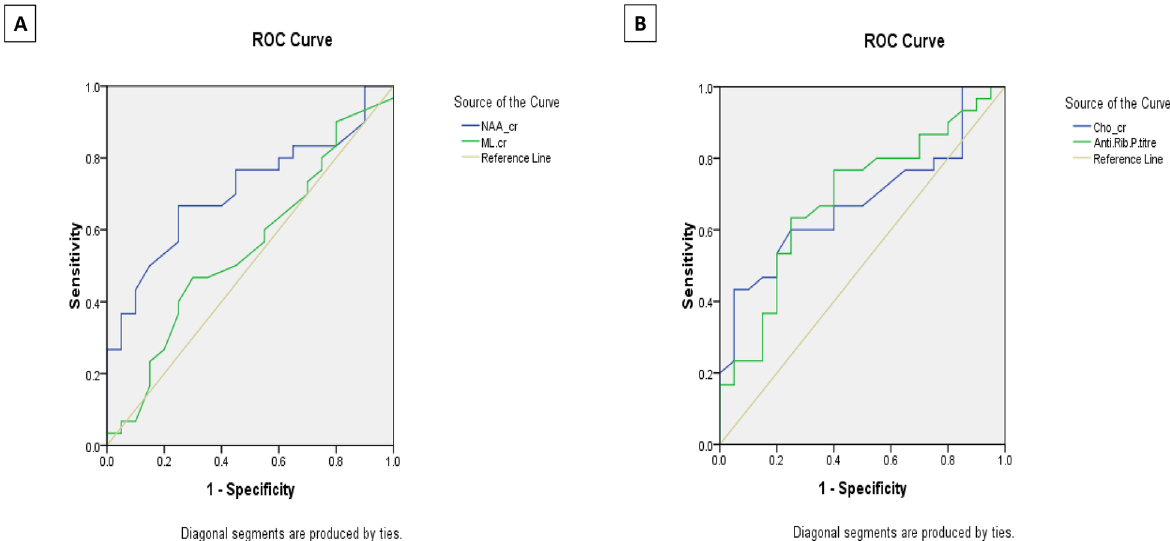
Fig. 1 A Receiver operating characteristic (ROC) curve for NAA/Cr and mI/Cr for differentiating active and inactive SLE. B ROC curve for Cho/Cr and anti‑ribosomal P titer for differentiating active and inactive SLE ( n